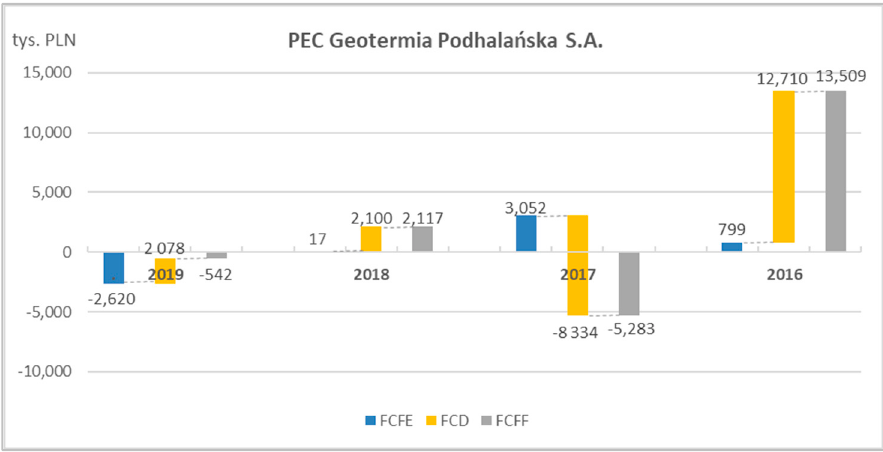
Figure 5. Formation of FCFE, FCD and FCFF in PEC Geotermia Podhala ń ska S.A. Source: Own study on the basis of: [51].